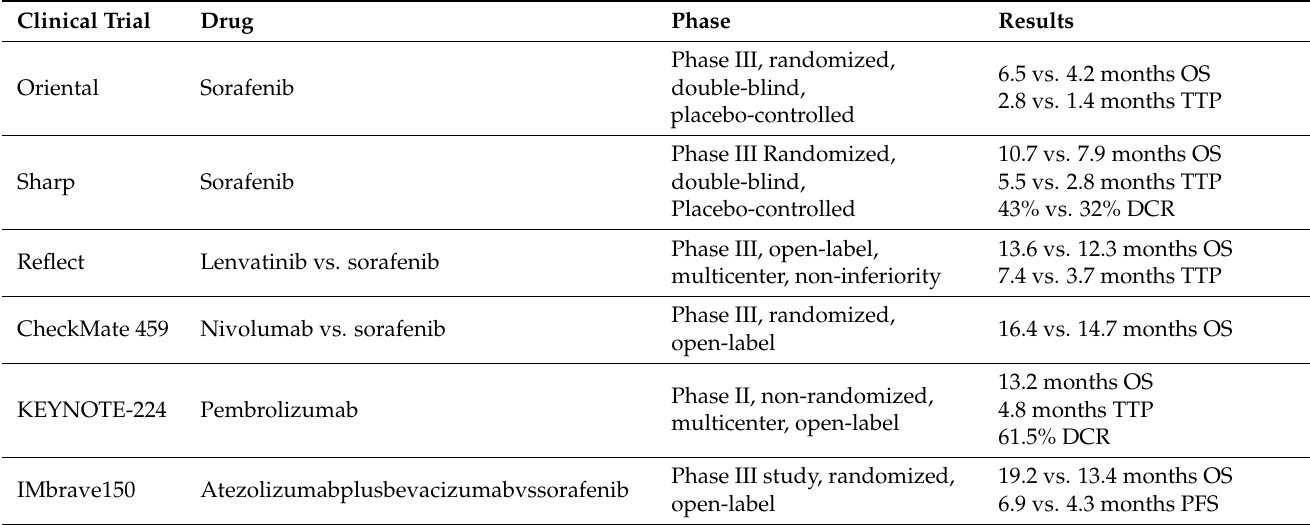
Table 1. Summary of the results from clinical trials in HCC with